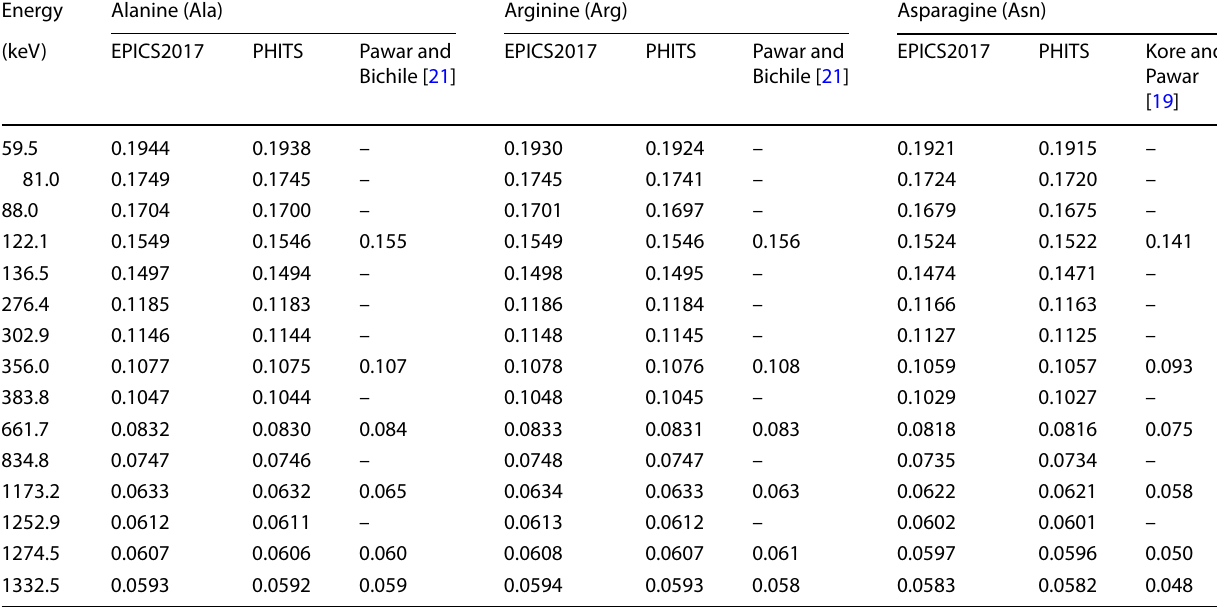
Table 2 Mass attenuation coefficients ( cm 2 g − 1 ) of alanine, arginine, and